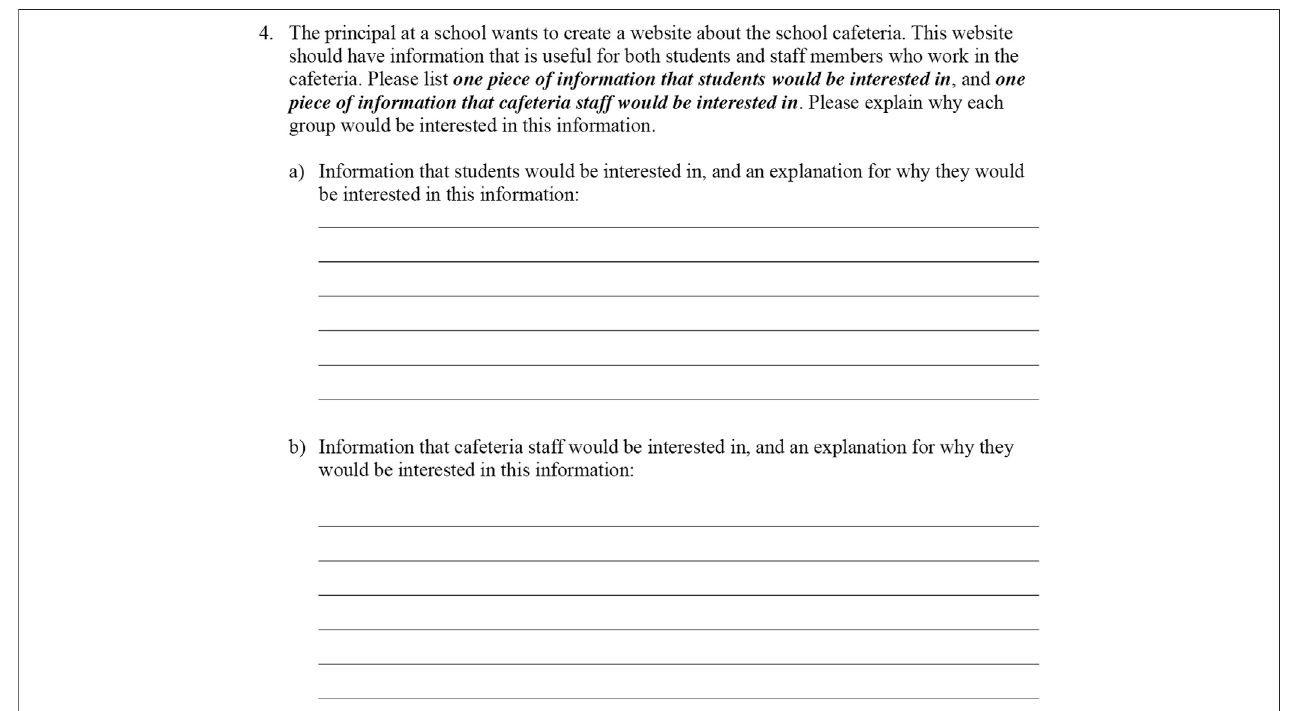
FIGURE 3 | Sample item: Unit 2 assessment, item 4.